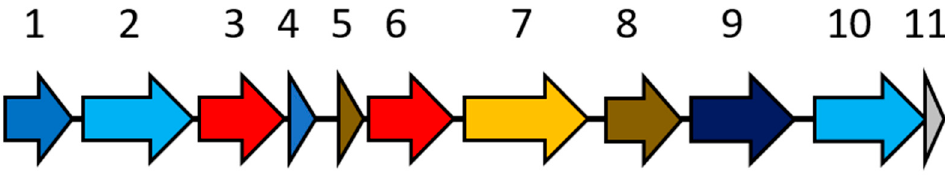
Figure 6. Organization of putative methanogenic naphthalene degradation gene cluster of binned Clostridiaceae scaffold 1013. Protein functions were predicted based on sequence orthology to NaphS2 loci and BLASTP searches. Protein annotation: 1. enoyl CoA hydratase; 2. Class III CoA transferase; 3. FAD-dependent arylcarboxyl-CoA reductase; 4. enoyl-CoA hydratase/isomerase/hydrolase; 5. 3-